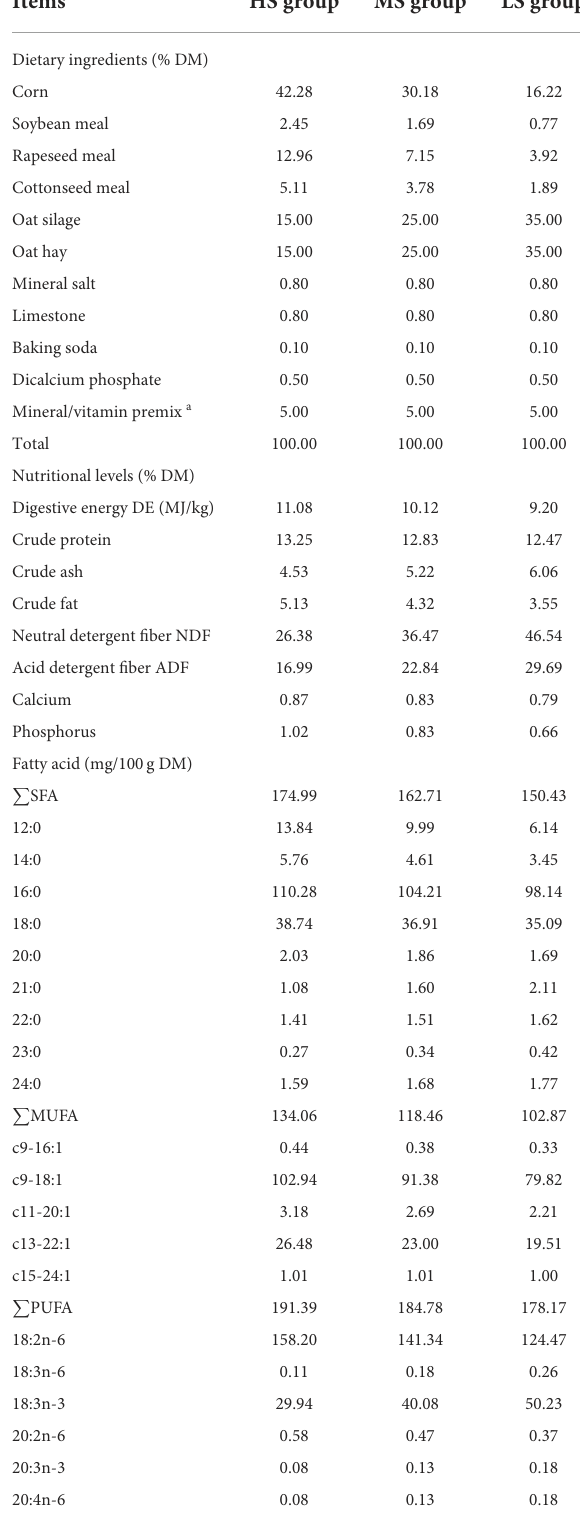
TABLE 1 Dietary ingredients, nutrients, and fatty acid composition of three different energy level diets (dry matter basis). Items HS group MS group LS group Dietary ingredients (%